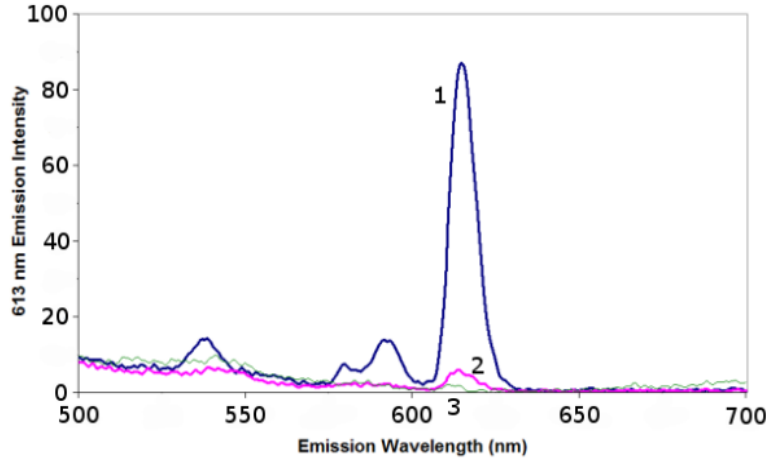
FIGURE 7. Eu/TTA (1  10 – 3 M ) 613-nm emission in distilled water solutions of (1) NaCl, (2)